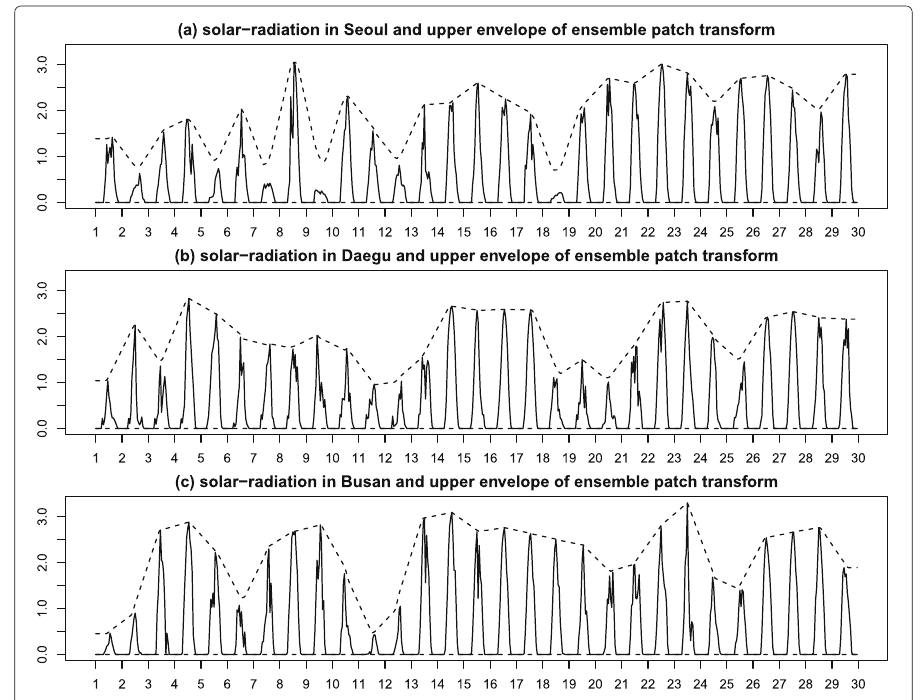
Fig. 19 Solar radiation data in Seoul, Daegu, and Busan in September 2003